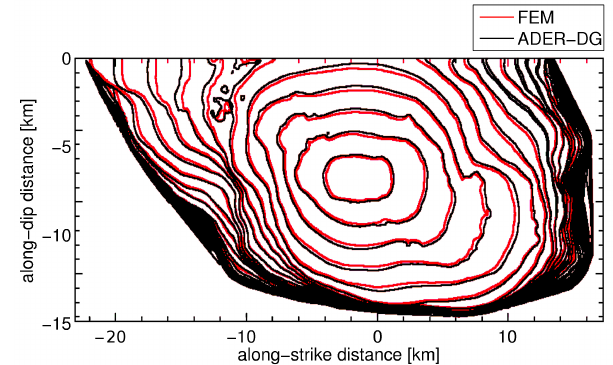
Fig. 4. Rupture front every 0 . 5s of problem TPV17 with hetero- geneous initial stress conditions. The ADER-DG rupture front is indicated in black, the FEM comparison solution in